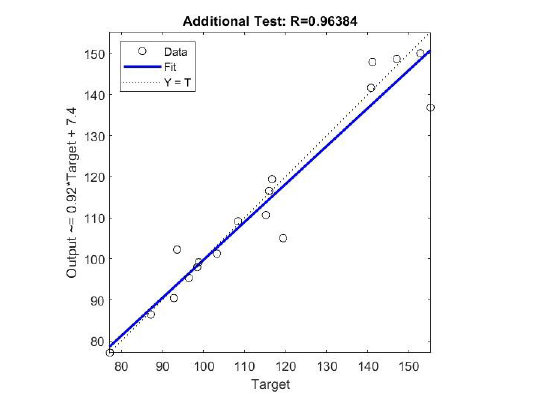
Figure 12. Regression analysis of additional test